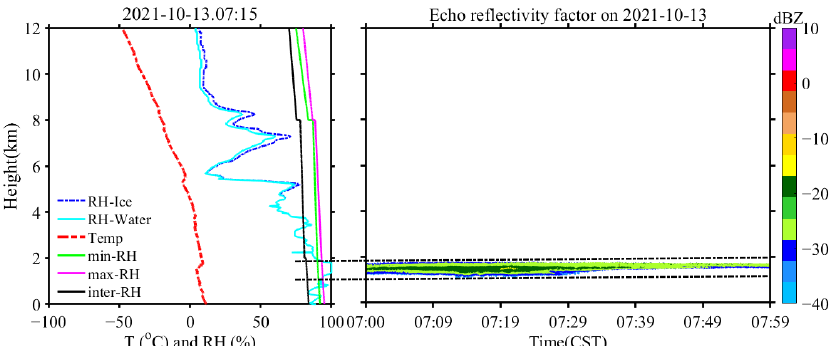
Figure 1. Low cloud detected by the radiosonde and MMCR on 13 October 2021 (radiosonde tem- perature and RH profile ( left ), reflectance factor THI from the MMCR ( right )).